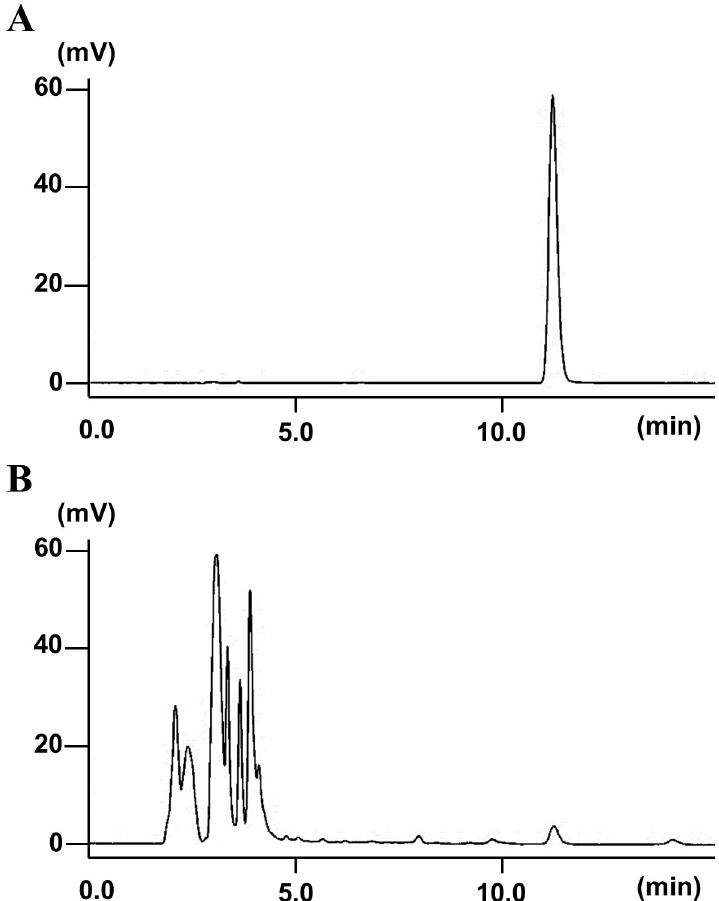
Fig 2. Typical HPLC chromatograms of a standard solution (20 μ g/mL CM) (A) and MeOH extract of GM-S (50 mg/ mL)